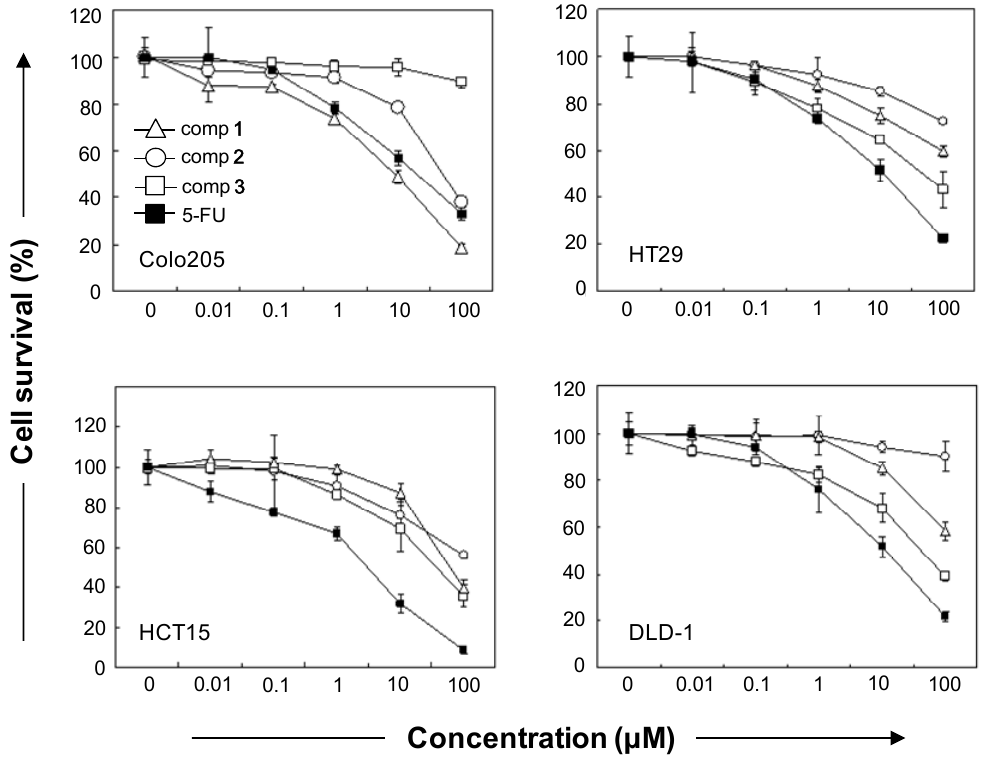
Figure 2. Effects of AC1-derived compounds on cell survival inhibition. Colon